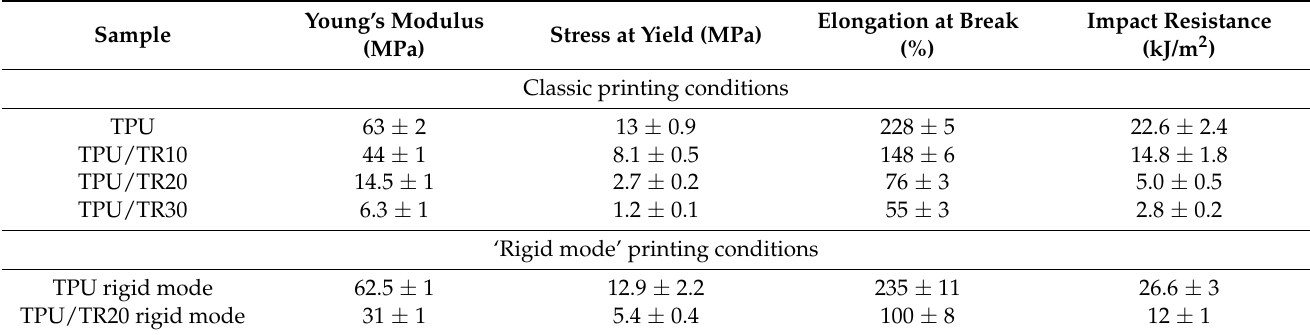
Figure 8. Stress-strain curves of TPU(/TR) samples produced by flex ( A ) and rigid ( B ) mode printing. Digital images after tensile and impact strength tests ( C ). Table 4. Tensile and impact strength tests results of TPU/TR printed